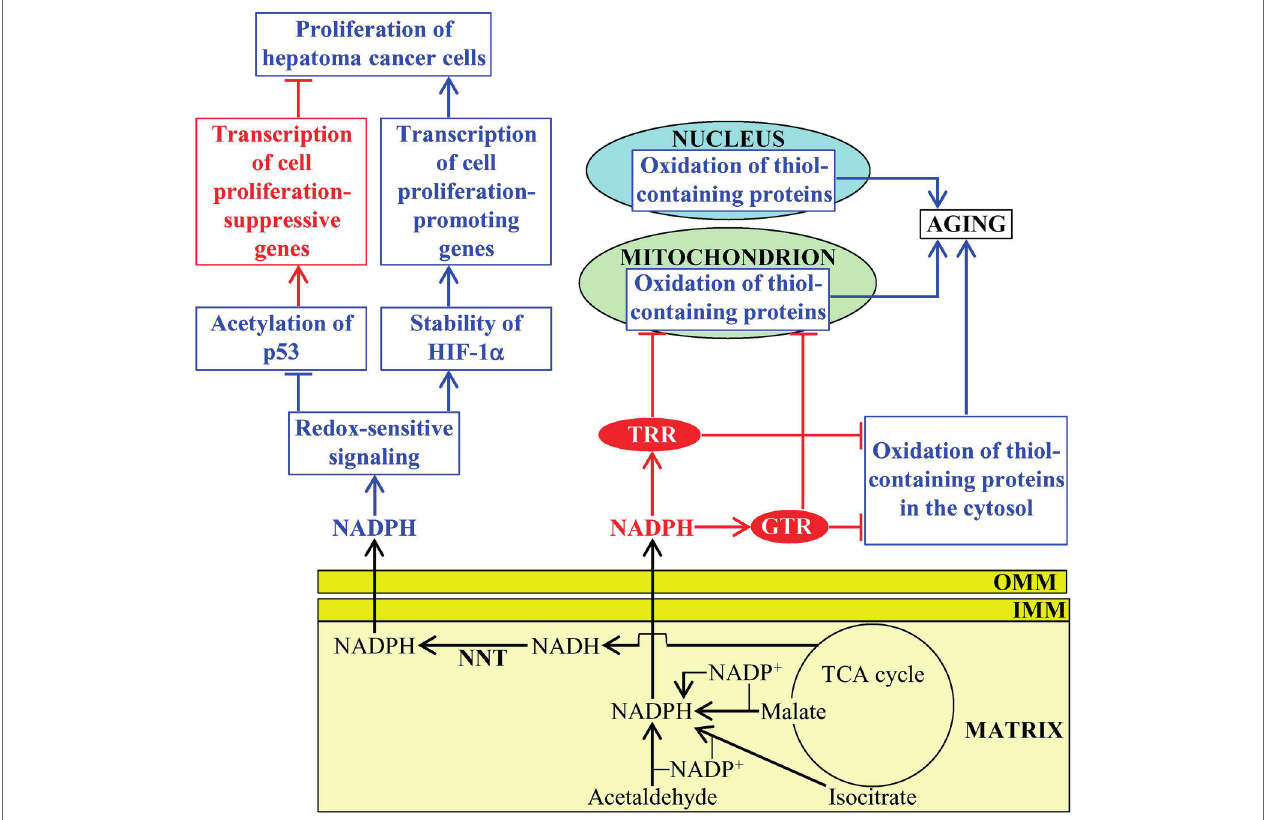
FIGURE 2 | NADPH produced in mitochondria has a significant impact on aging and aging-associated diseases. In budding yeast, mitochondria-generated NADPH donates electrons for the thioredoxin and glutathione reductase systems (TRR and GTR, respectively), both of which delay aging by preventing oxidative damage of many thiol-containing proteins in mitochondria, the nucleus, and the cytosol. In mammals, the nicotinamide nucleotide transhydrogenase (NNT)- dependent production of mitochondrial NADPH contributes to tumor suppressor protein p53 acetylation, transcription factor HIF-1 α (hypoxia-inducible factor 1 α ) stability, p53-dependent transcription of cell proliferation-suppressive genes, and HIF-1 α -dependent transcription of cell proliferation-promoting genes in cancer cells. Activation arrows and inhibition bars for NADPH molecules that are shown in red color denote pro-aging (displayed in blue color) or anti-aging (displayed in red color) processes, and anti-aging proteins are displayed in red color. Activation arrows and inhibition bars for NADPH molecules that are shown in blue color denote pro-cancer (displayed in blue color) or anticancer (displayed in red color) processes. See the text for additional details. Abbreviations: IMM, inner mitochondrial membrane; OMM, outer mitochondrial